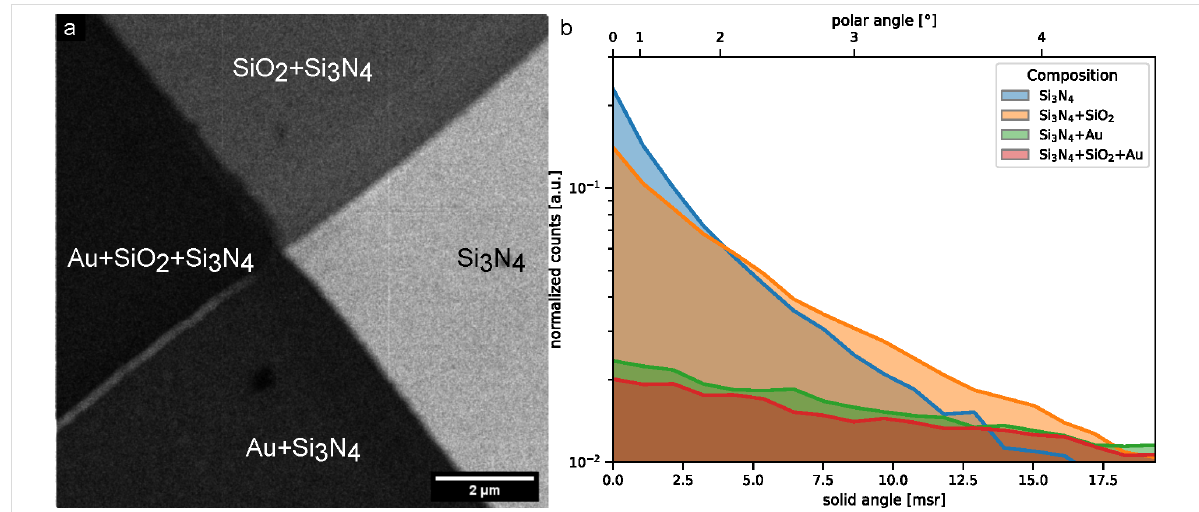
Figure 3: Bright-field image showing contrast due to the dependence of the exit angle on the material and the thickness of the layer. (a) Bright-field STIM image with collection angle from 0 to 4.5° of a silicon nitride membrane with silicon dioxide deposited on the upper left half and gold deposited on the lower left half. (b) TRIDYN simulation of the angular distribution of the transmitted beam.